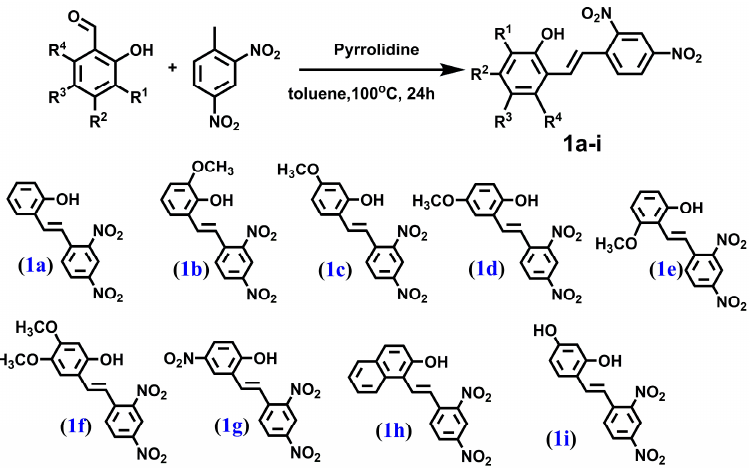
Figure 6. The structure of: ( E )-2-hydroxy-2 ′ ,4 ′ -dinitrostilbene ( 1a ), ( E )-2-hydroxy-3-methoxy-2 ′ ,4 ′ - dinitrostilbene ( 1b ), ( E )-2-hydroxy-4-methoxy-2 ′ ,4 ′ -dinitrostilbene ( 1c ), ( E )-2-hydroxy-5-methoxy- 2 ′ ,4 ′ -dinitrostilbene ( 1d ), ( E )-2-hydroxy-6-methoxy-2 ′ ,4 ′ -dinitrostilbene ( 1e ), ( E )-2-hydroxy-4,5-di- methoxy-2 ′ ,4 ′ -dinitrostilbene nitrostyryl)naphthalen-2-ol ( 1h ) and ( E )-2,4-dihydroxy-2 ′ ,4 ′ -dinitrostilbene ( 1i ).